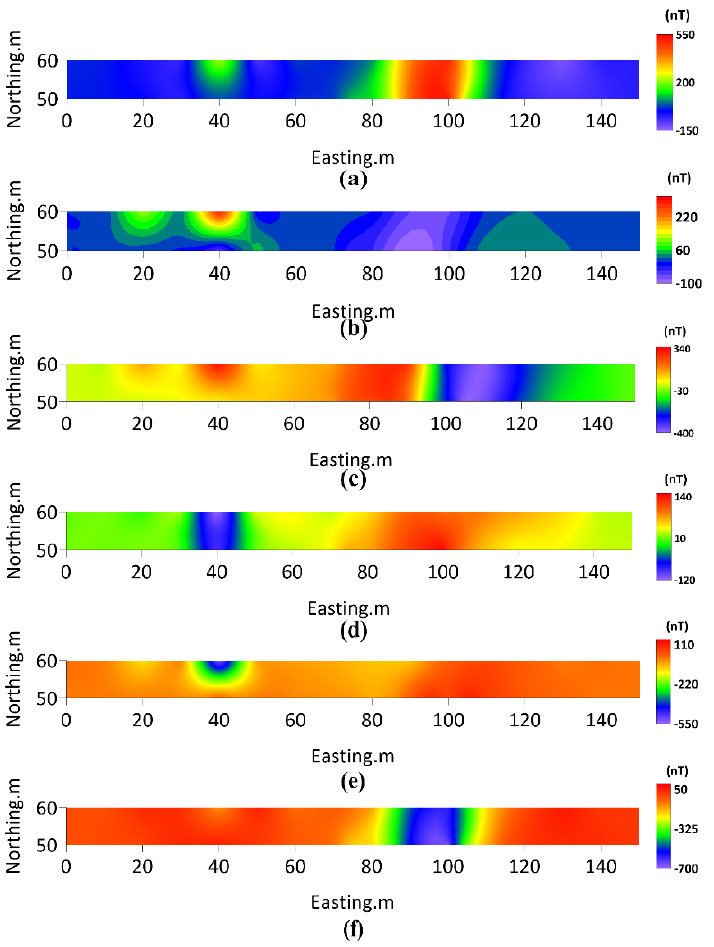
Figure 16. Plot of independent component data for each of the 50 mN and 60 mN measurement lines. ( a )